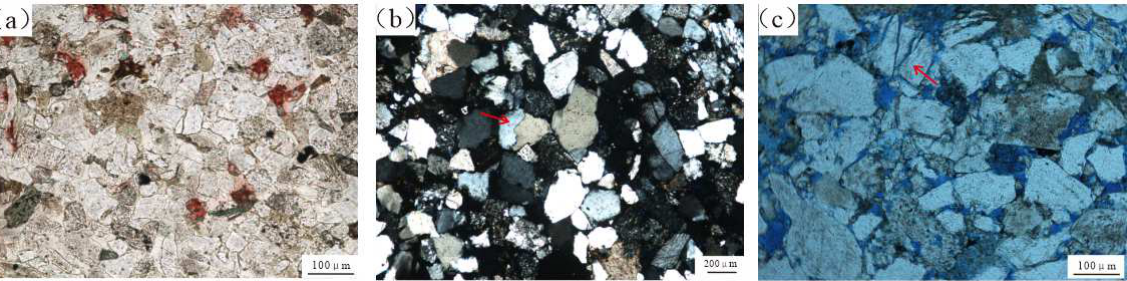
Figure 13. Compaction characteristics of Ek1 Formation in the Wang Guantun area ( a ) Well G50-5 1917.5 m ( b ) Well G106 3053.75 m, arrow refers to concave–convex contact ( c ) Well G11-13 2467.34 m, arrow refers to fracture.